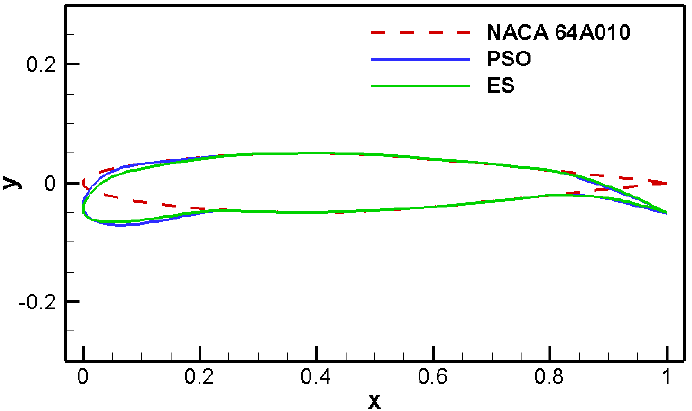
Figure 4. Final solutions Particle Swarm Optimizer (PSO) (four generations, first type) and ES (eight generations, second type) along with the original airfoil.